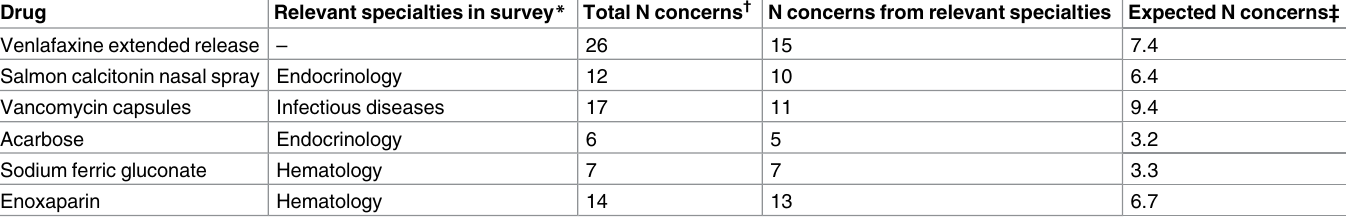
Table 6. Specialists in the relevant primary practice areas for each drug reported more concerns.